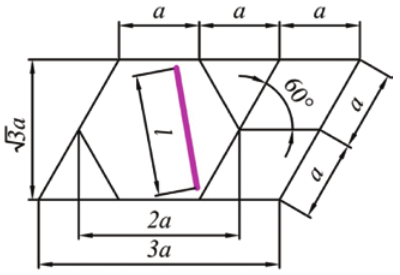
Figure 9: The combined cell in the multi-shaped crack